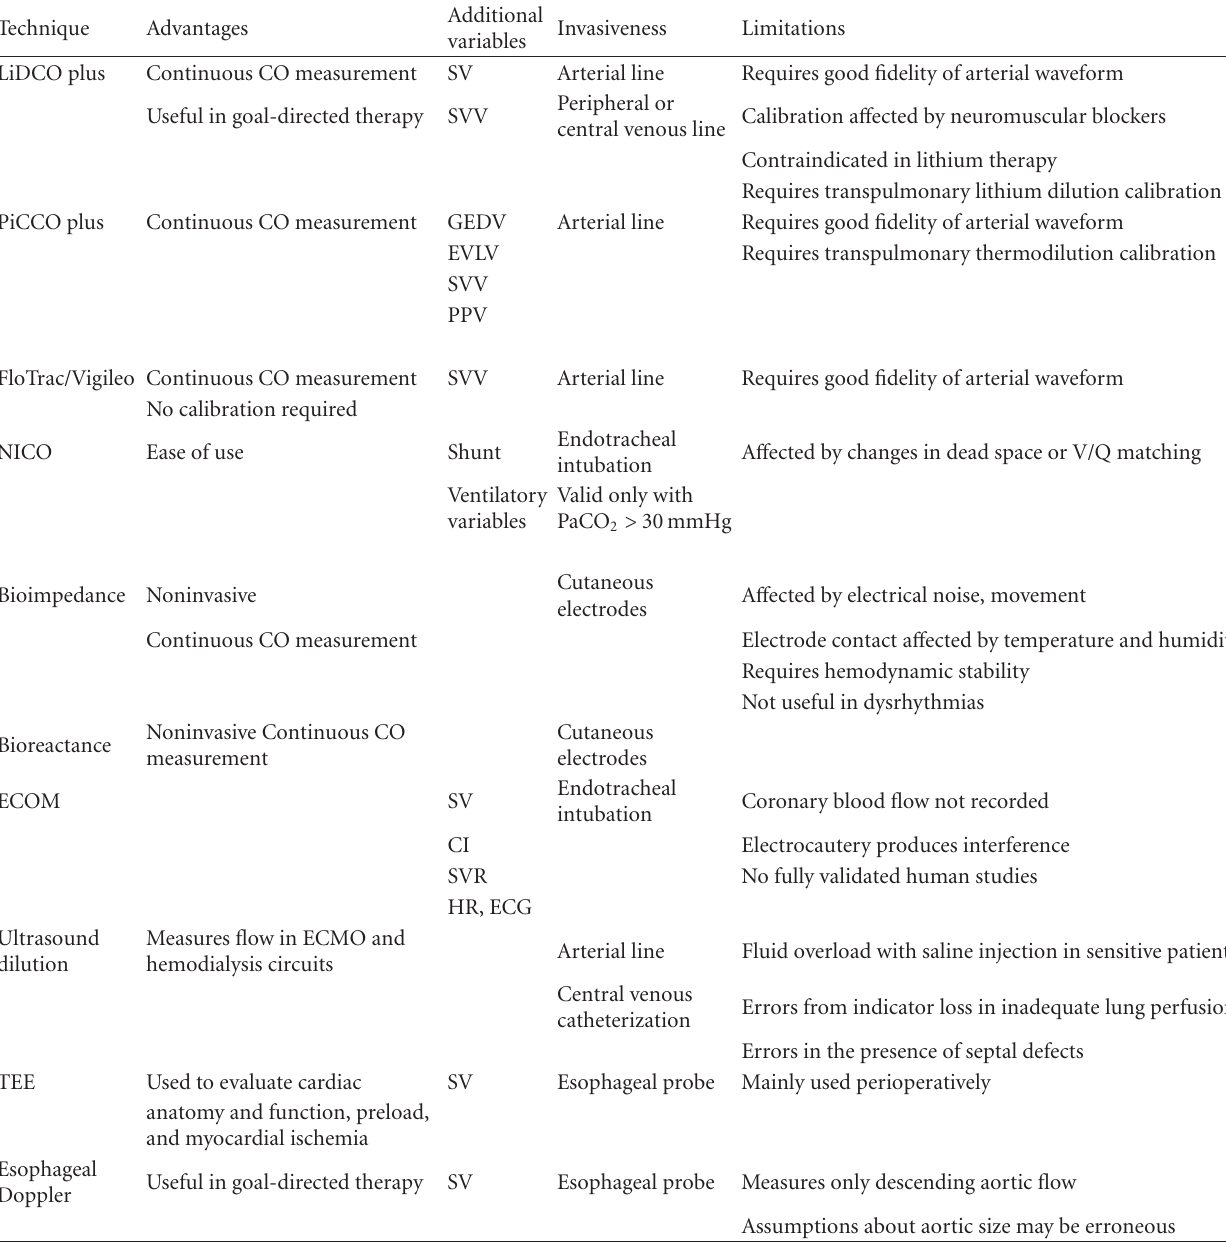
Table 1: Comparison of minimally invasive cardiac output monitoring techniques (CI: cardiac index, HR: heart rate, and ECG: electro-